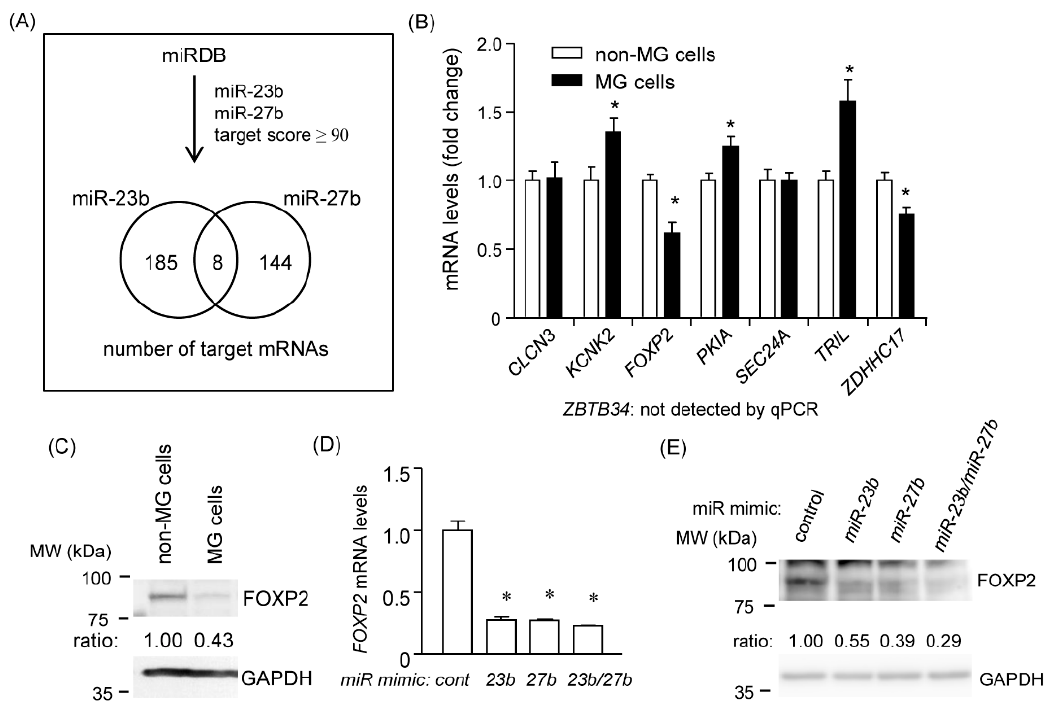
Figure 6. FOXP2 as a potential target of miR-23b and miR-27b . ( A ) The number of candidate target mRNAs of miR-23b or miR-27b based on miRDB is shown in a Venn diagram. ( B ) mRNA levels of CLCN3 , KCNK2 , FOXP2 , PKIA , SEC24A , TRIL , ZDHHC17 , and ZBTB34 were determined using RT-qPCR in non-MG cells and MG cells. Expression of ZBTB34 mRNA was not detected by RT-qPCR. ( C ) Amounts of FOXP2 protein in non-MG cells and MG cells were determined using western blotting with GAPDH as a loading control. ( D ) FOXP2 mRNA levels were determined in non-MG cells with mimic miR-23b and / or miR-27b transfection and RT-qPCR. ( E ) Amounts of FOXP2 protein in non-MG cells with mimic miR-23b and / or miR-27b transfection were determined using western blotting with GAPDH as a loading control. The results of western blotting with an anti-FOXP2 antibody were quantified by densitometry, and the ratio of FOXP2 to GAPDH is shown in ( E ). MW, molecular weight.